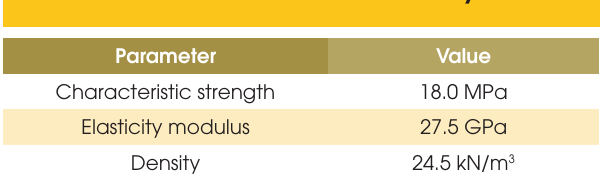
Table 5 – Concrete’s parameters